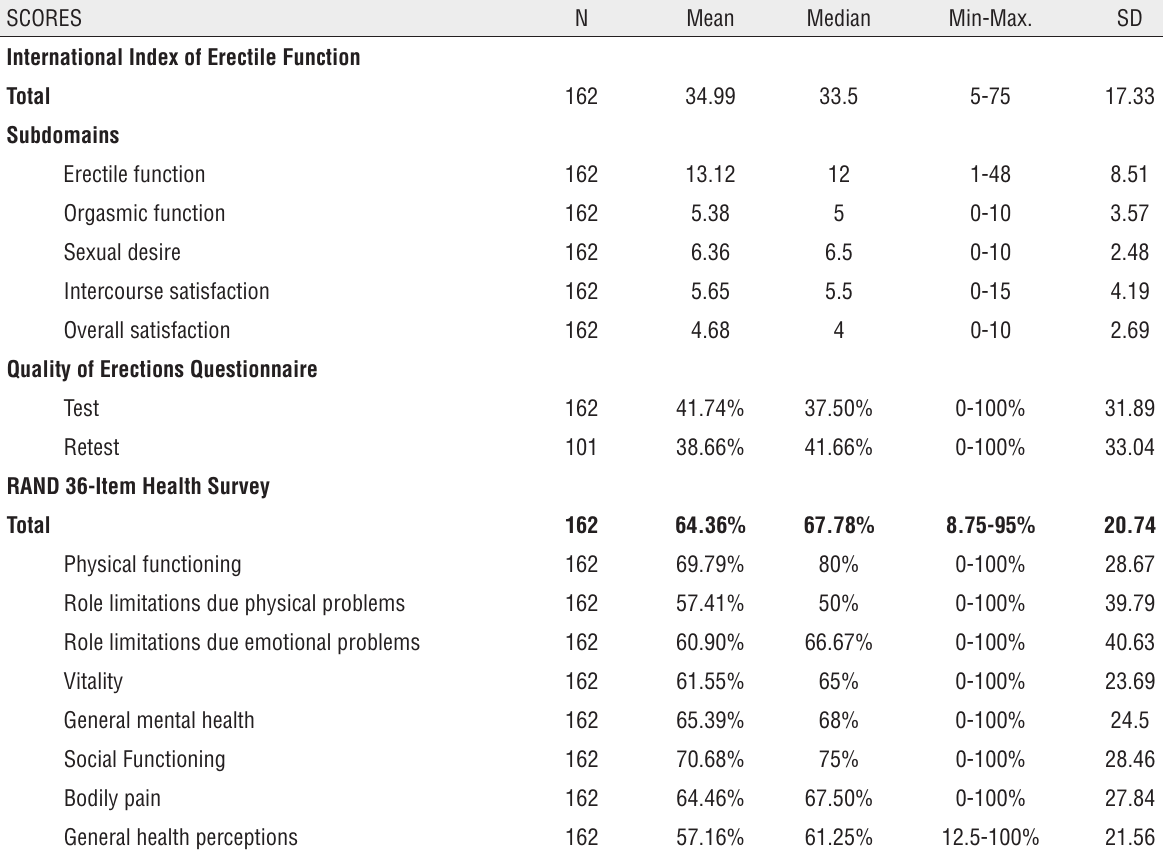
Table 3 – Scores of IIEF, QEQ and RAND 36-Itens for patients with erection dysfunction.